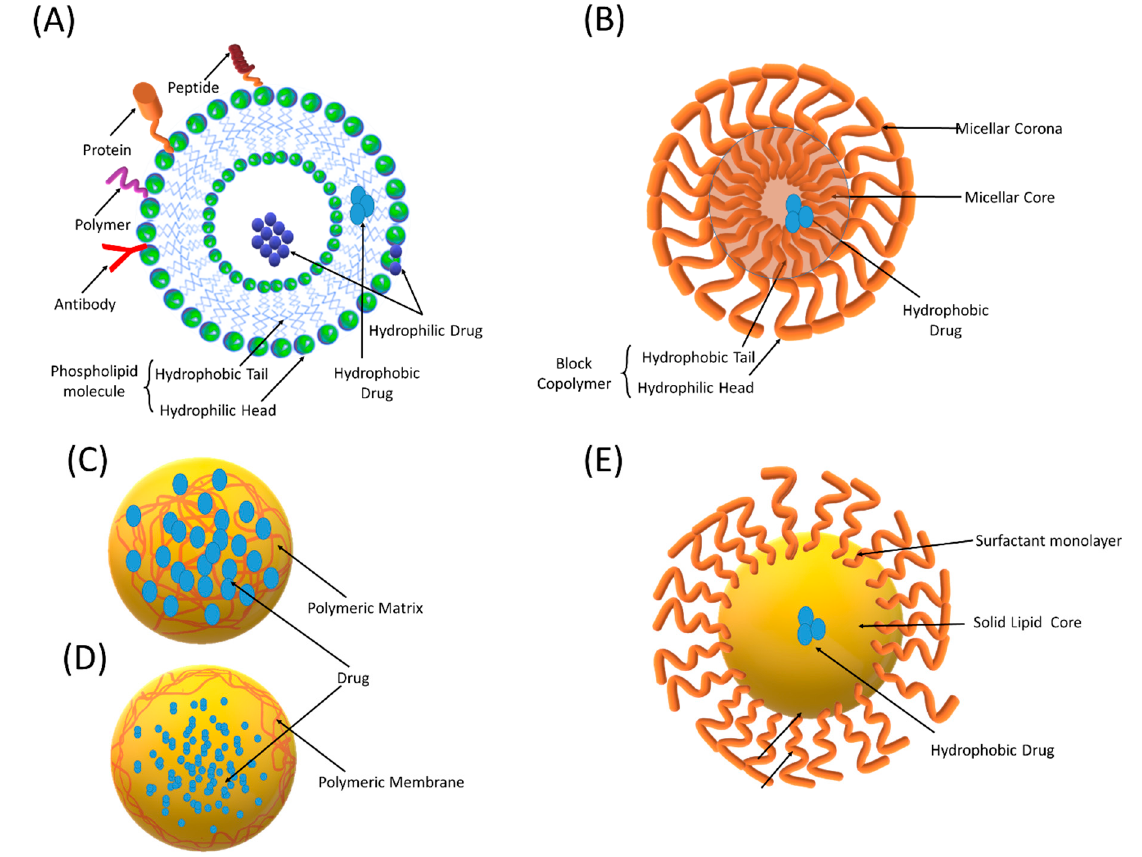
Figure 3. Schematic representation of different nano-sized drug delivery systems (NDDSs): ( A ) liposomes, ( B ) polymeric micelles, ( C ) nanospheres, ( D ) nanocapsules, and ( E ) solid lipid nanoparticles.